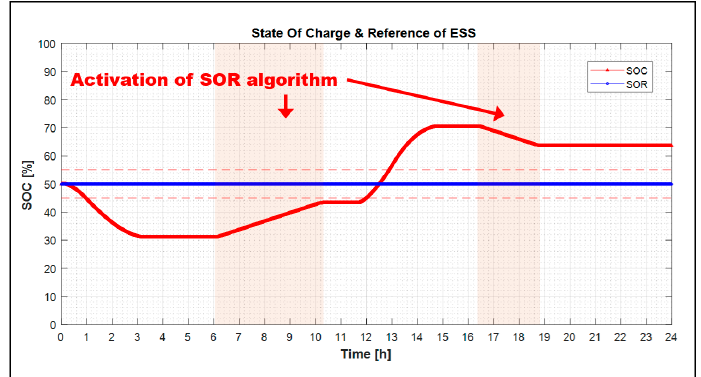
Figure 25. SOC pattern of ESS during a 24 h period.